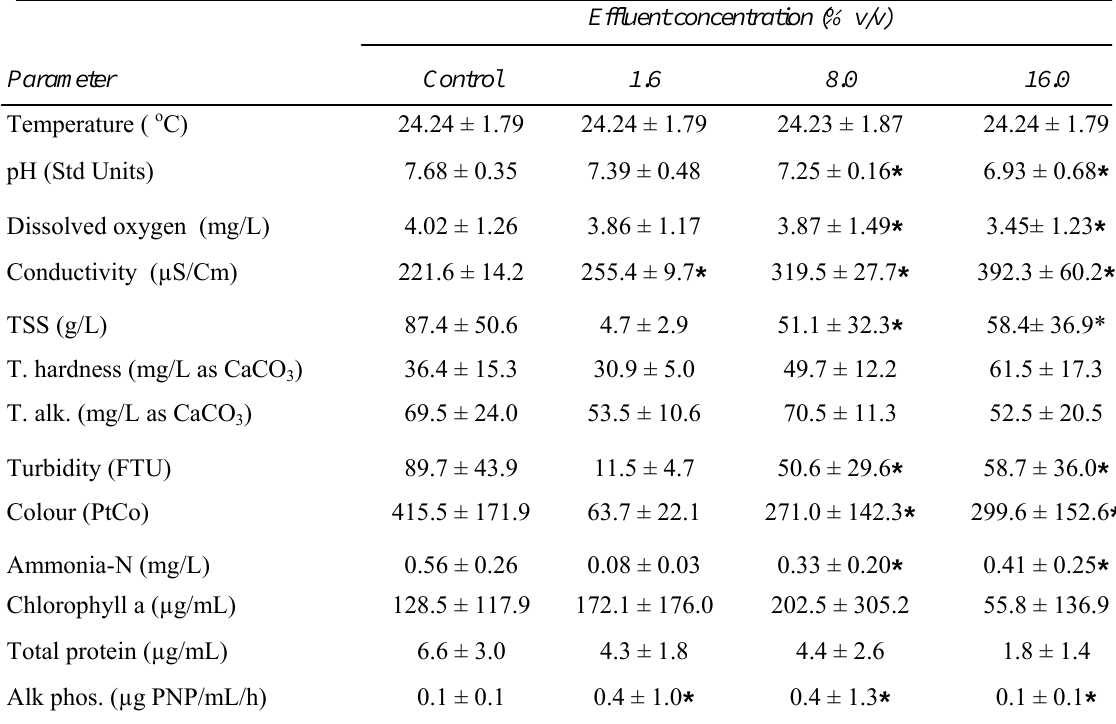
Table 3: Mean values of water quality parameters studied of control and treated microcosms with various concentrations of the effluent during the study (6 weeks of